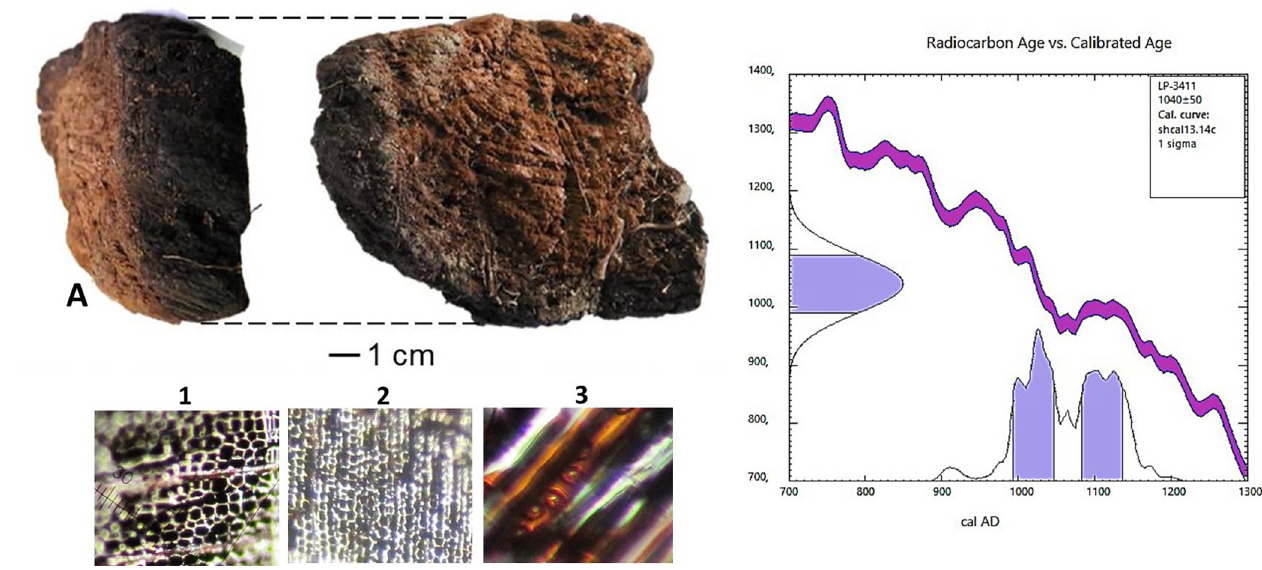
Fig 4. A- wood with charred face and 14 C (S1 Fig) dating. Sections: 1- cross, 2- radial axial, 3- tangential.